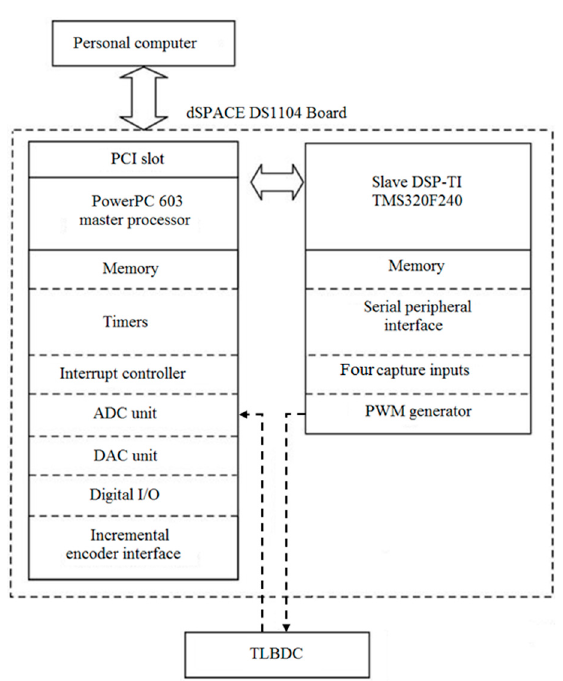
Figure 8. TLBDC Experimental setup.